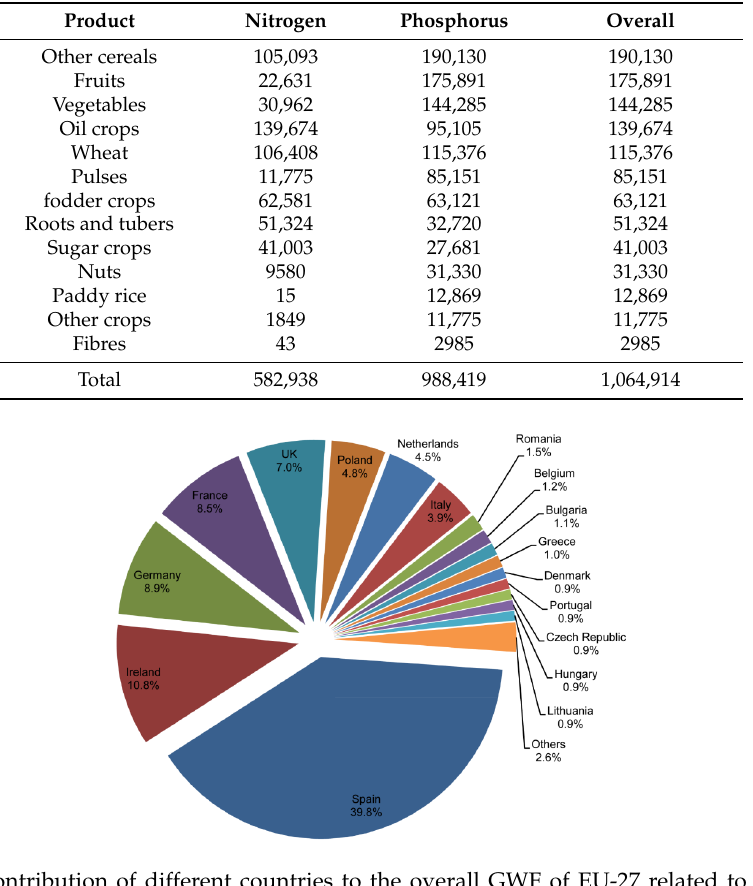
Table 2. Grey water footprint of production of the EU-27 (million m 3 per year). Period: 2007.